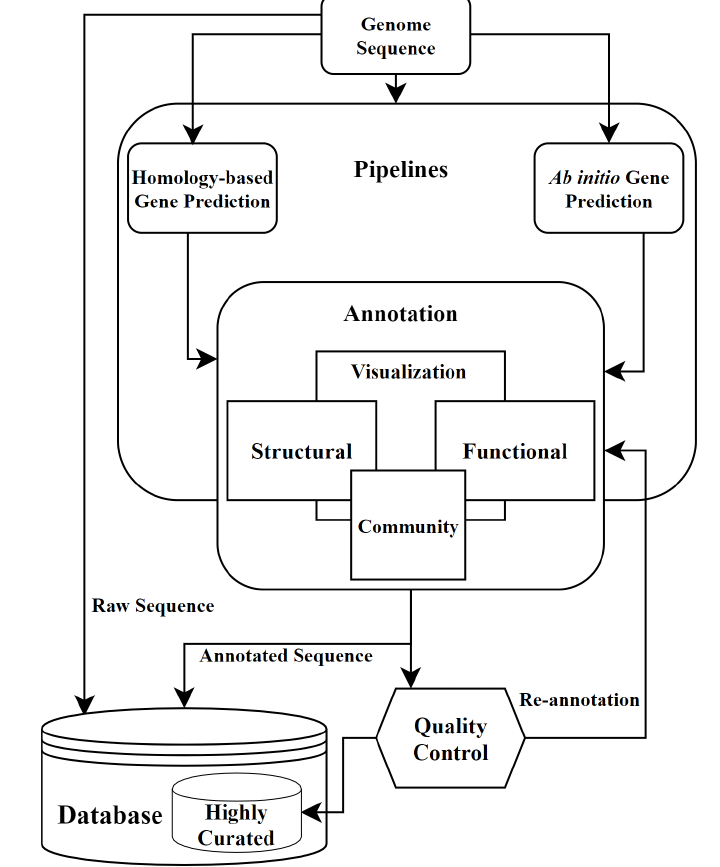
Figure 1. Genome annotation